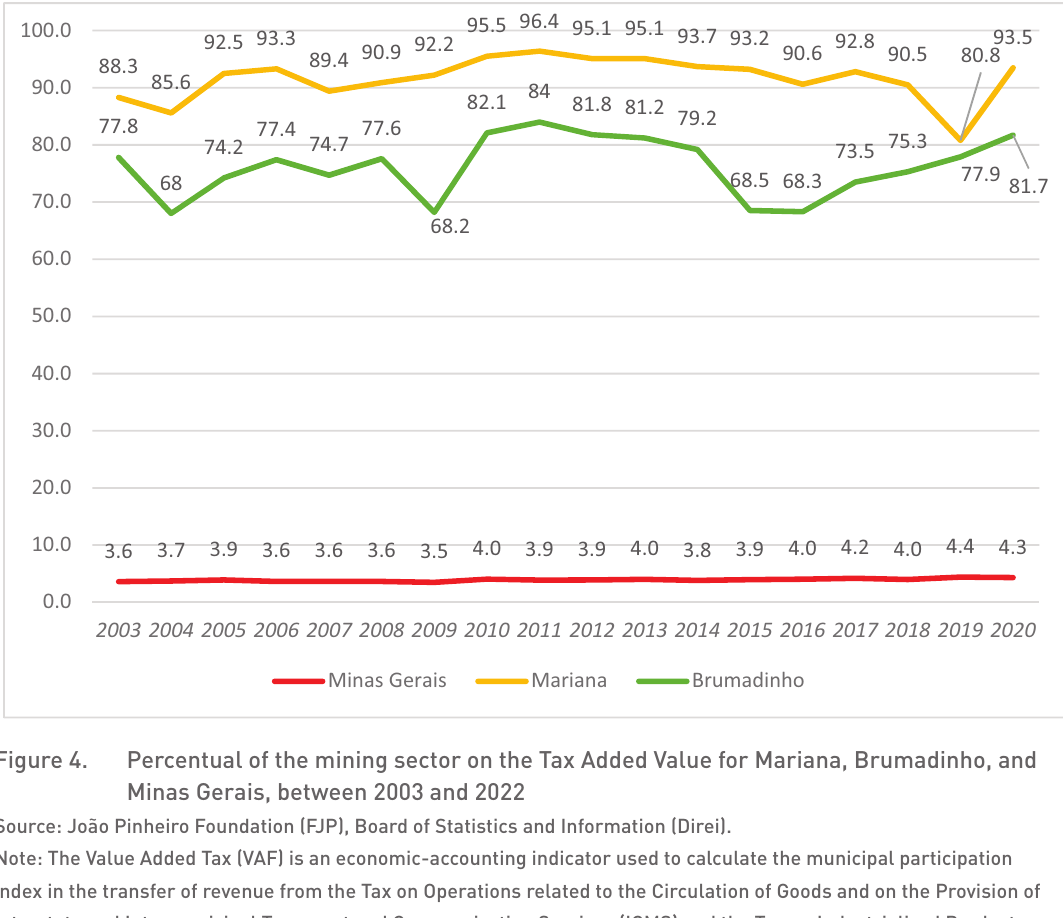
Figure 4. Percentual of the mining sector on the Tax Added Value for Mariana, Brumadinho, and Minas Gerais, between 2003 and 2022 Source: João Pinheiro Foundation (FJP), Board of Statistics and Information